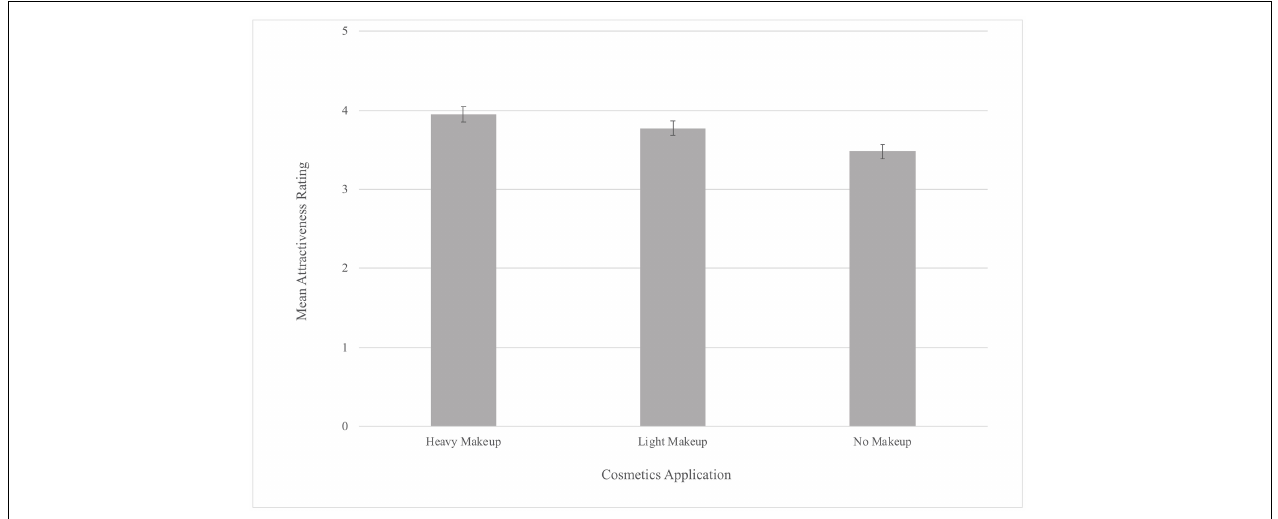
FIGURE 2 | Mean Attractiveness Ratings by Makeup Application (error bars represent 95% confidence intervals).